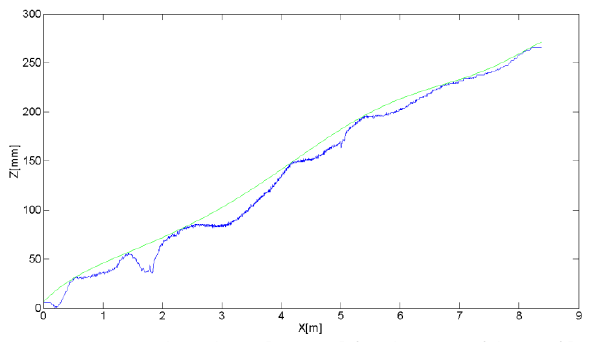
Figure 11. An eight order polynomial fitted on top of the profile The correlation coefficient 𝑃(𝑥) is computed according to the